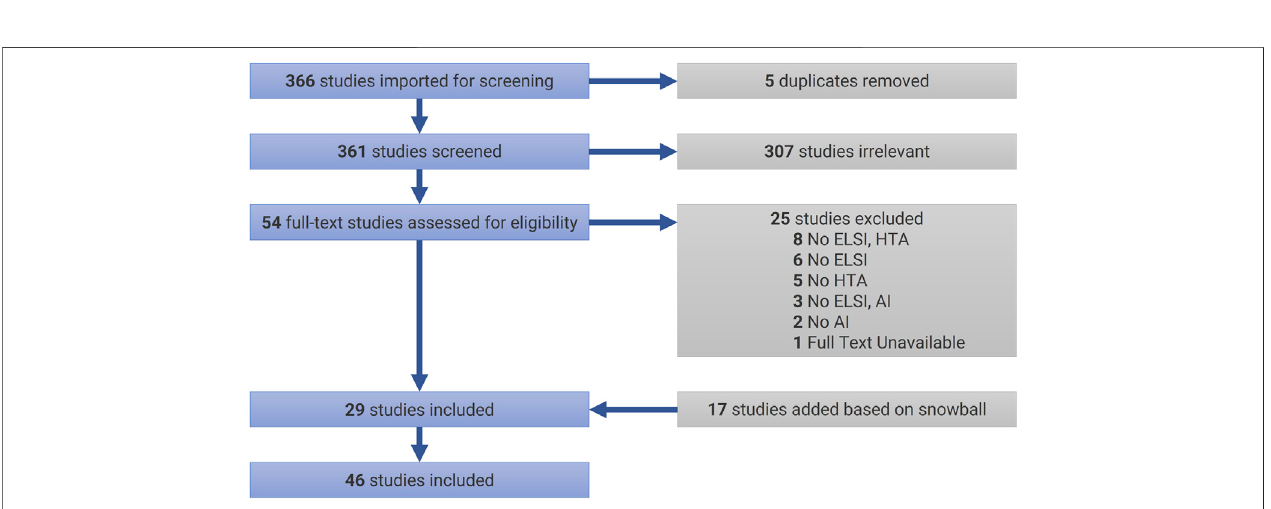
FIGURE 1 | PRISMA Flowchart. AI (cid:1) arti fi cial intelligence; ELSI (cid:1) ethical, legal, and social implications; HTA (cid:1) health technology assessment.